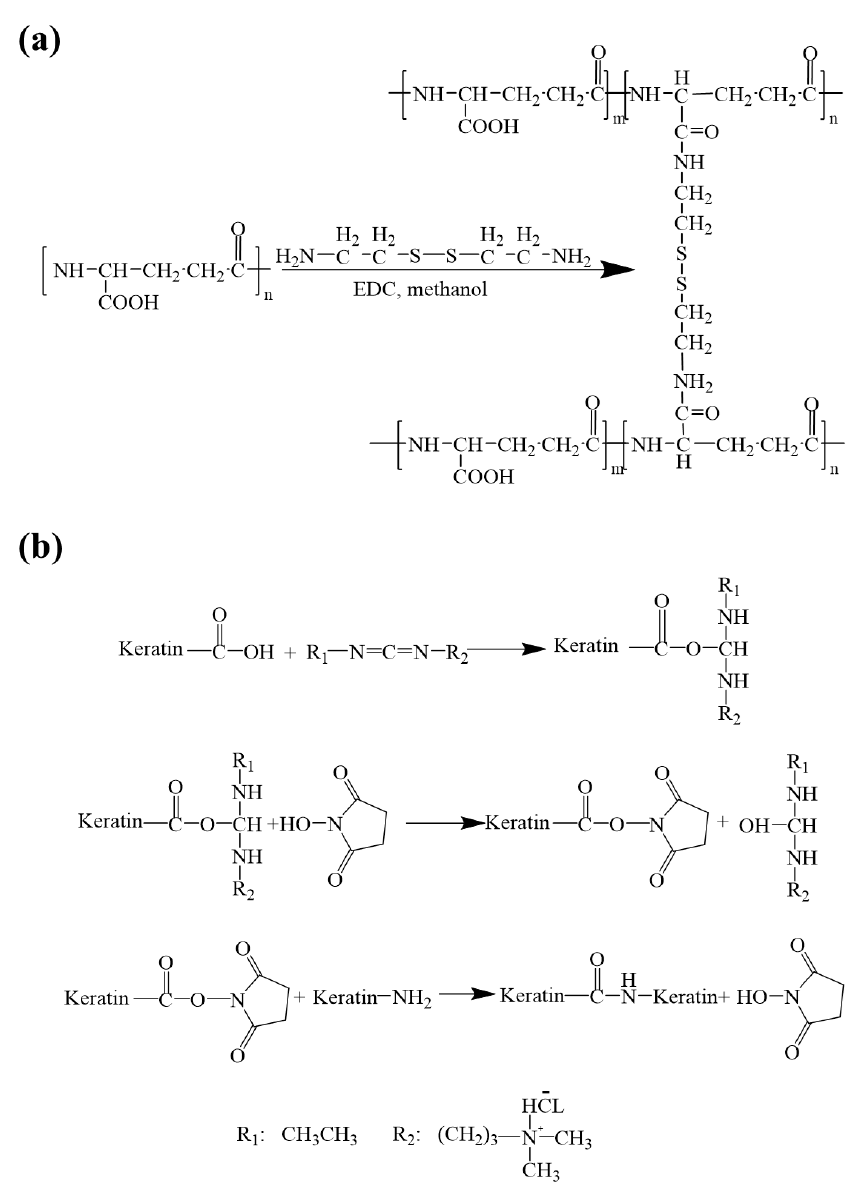
Figure 2. Schematic of the cross-linking reaction: ( a ) cross-linking between γ -PGA and cystamine molecules; ( b ) cross-linking between the keratin and the γ -PGA.